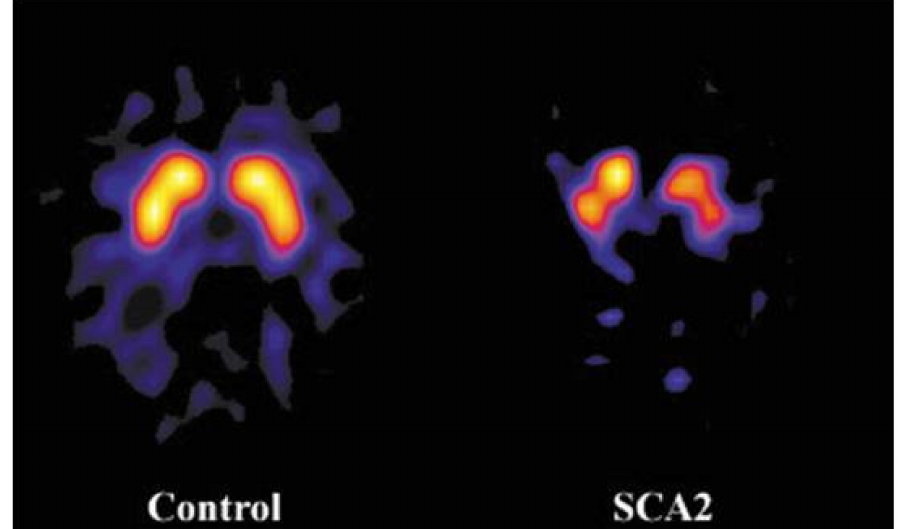
Figure 8. Axial [123I]FP-CIT single photon emission computed tomography scans at the level of the basal ganglia show marked and uniform reduction of the dopamine active transporter (DAT)tracer uptake in a symptomatic SCA2 gene carrier without parkinsonism (right) compared to a control subject (left).Modified and reproduced with permission from Varrone A, Salvatore E, De Michele G, Barone P, Sansone V, Pellecchia MT, Castaldo I, Coppola G, Brunetti A, Salvatore M, et al.: Reduced striatal